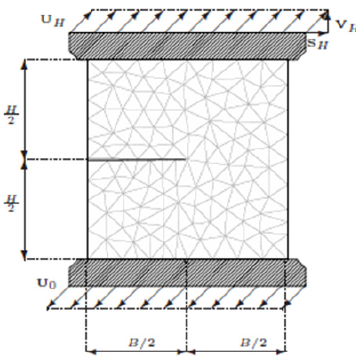
Figure 1: Typical BVP: strip with a straight crack in “mixed” mode.